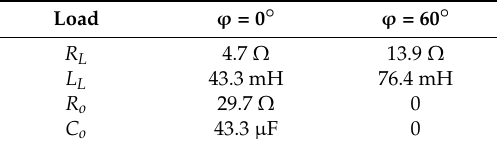
Table 3. Load parameters.